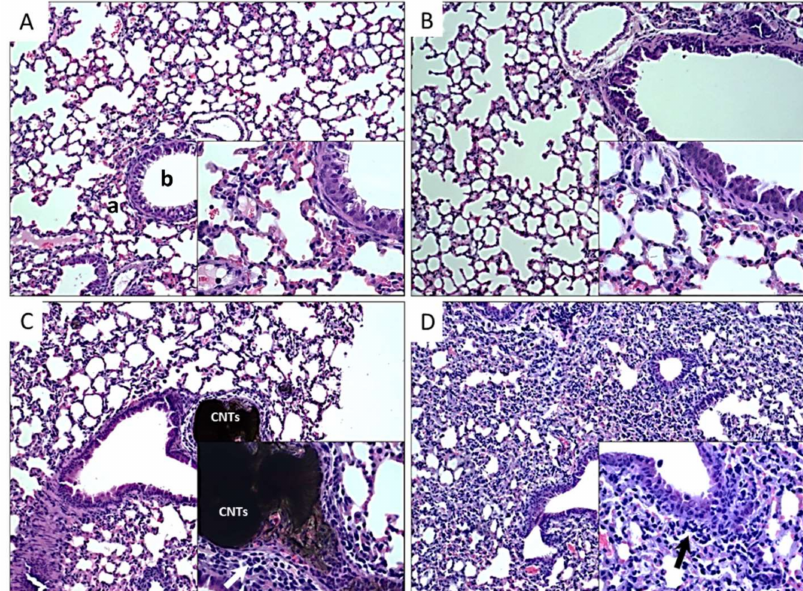
Figure 5. Histopathological findings in lungs of mice exposed to different types of CNTs. Microphotographs show lung sections of mice exposed to: A , control group non exposed, the normal morphology of bronchiole ( b ) and alveoli ( a ) is shown; B , P-CNTs exposed group. C , UP-CNTs exposed group, accumulation of CNTs in the artery, and inflammatory infiltrate in alveolar walls (arrow). D , FITC-CNTs exposed group, inflammatory infiltrate (arrow), of note is the decrease of the alveolar sacs in the lung. Microphotographs are representative of one experiment. Magnification 10X. Insets show magnification at 40 × . H&E staining.